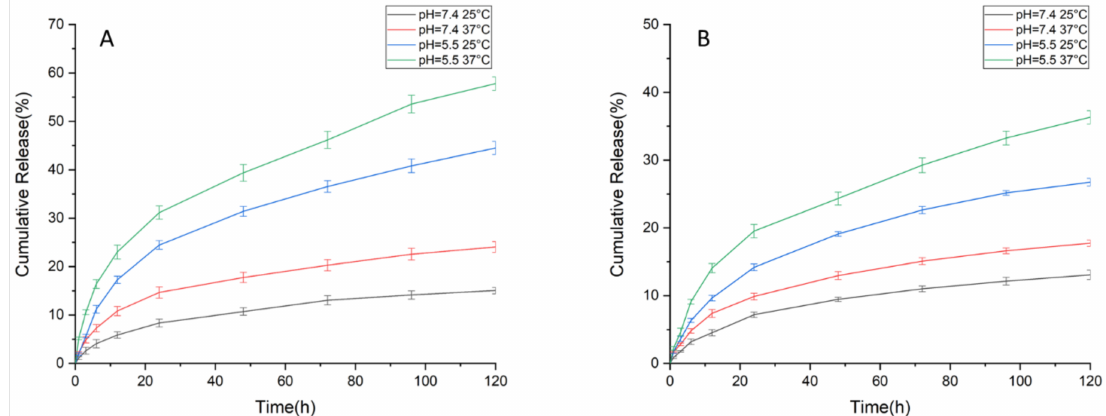
Figure 4. Drug release profile of ( A ) Rose Bengal and ( B ) CUR at two pH values and two temperatures. According to the results, 57 % of Rose Bengal was released at pH = 5.5 and 37 ◦